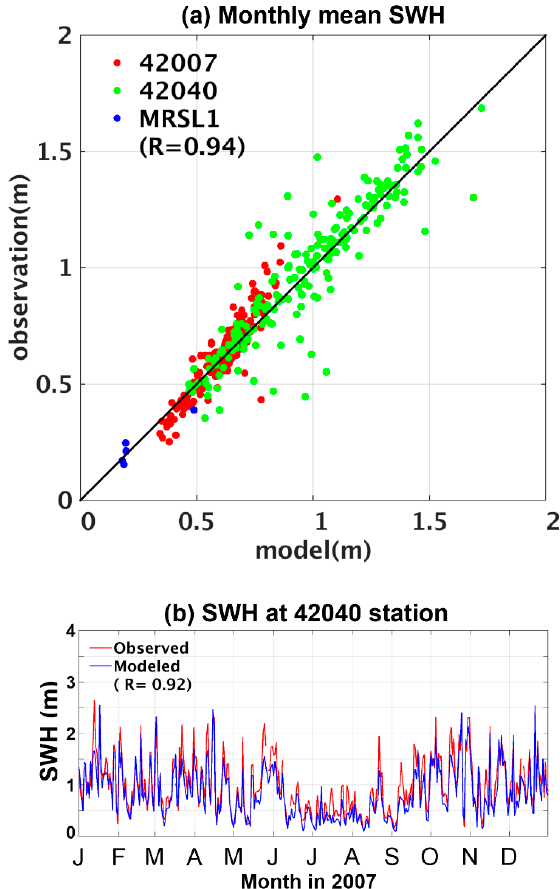
Figure 3. Comparison between observed and modeled monthly mean significant wave height from 1993 to 2012 at three stations ( a ), and significant wave height time series comparison at 42040 station in 2007 ( b ).